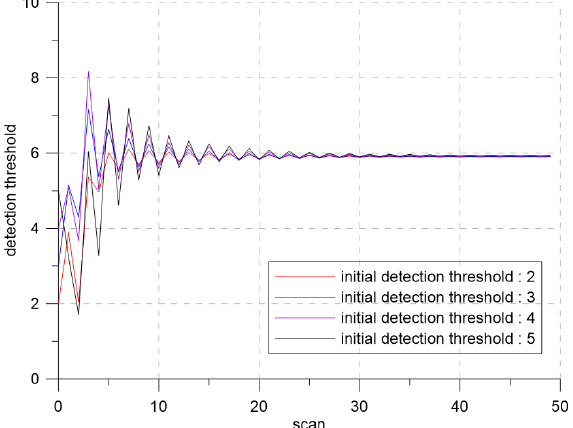
Figure 14. The detection threshold according to each initial detection threshold.